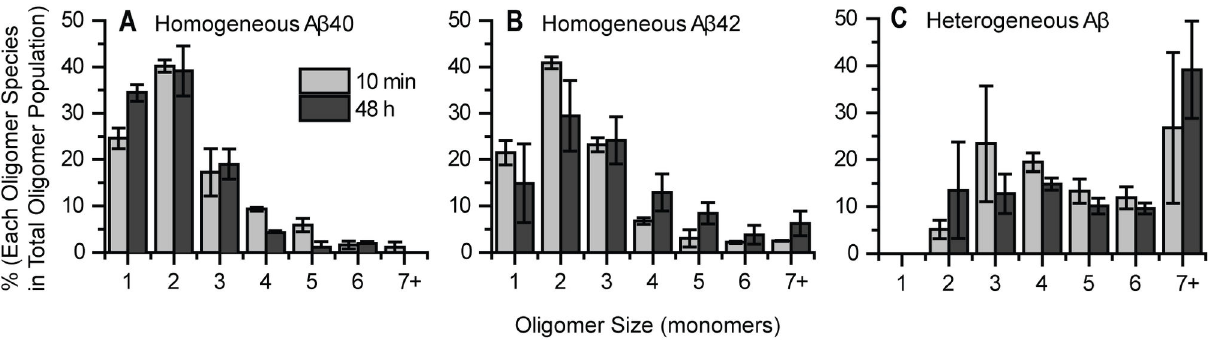
Figure 6. Heterogeneous oligomers are larger than homogeneous oligomers. (A) Homogeneous Aβ40 remains mainly dimeric on the neurites over 48 hours. (B) Homogeneous Aβ42 also forms mainly dimeric with slight increase in size over 48 hours. (C) Heterogeneous species contains mainly trimer and tetramer and many other oligomers larger than heptamer. The size of heterogeneous species was calculated by summing the number of Aβ40 and Aβ42 in that particular mixture. Percentages of each condition were calculated from two different experiments, at least 5 images each. Each image contained at least 50 oligomers. Error bars represent standard deviation of the mean. doi: